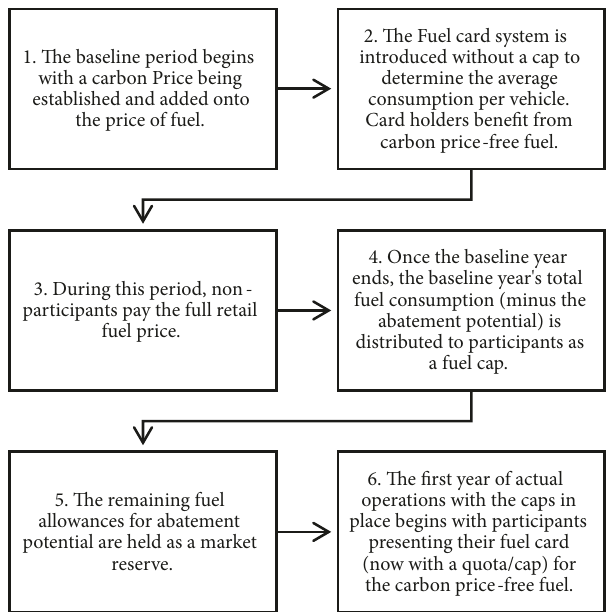
Figure 2: Baseline period–steps in determining the per-vehicle fuel